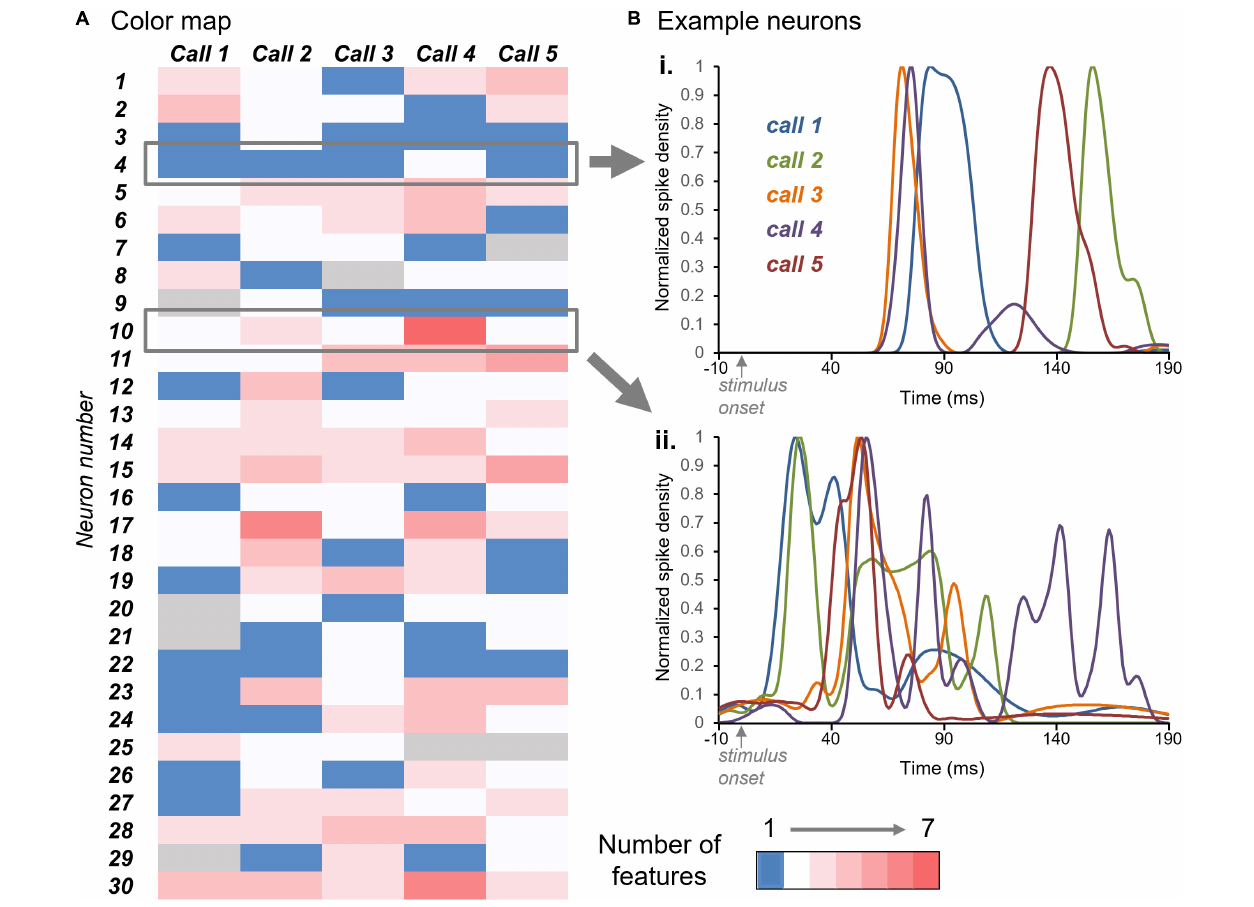
FIGURE 4 | (A) Color map of numbers of response features for the responses of 30 neurons ( y -axis) across the five BBVs ( x -axis). Blue indicates single response features and white through red indicate increasing numbers of features, up to seven. Gray indicates the lack of response to a specific call. (B) Normalized spike density functions for two neurons indicated by the gray boxes in (A) . Spike density functions for the responses to all five calls are plotted together. For the neuron in (i) , the number of response features was one for four of the calls, and two for one of the calls. For the neuron in (ii) , the numbers of response peaks across calls ranged from two to